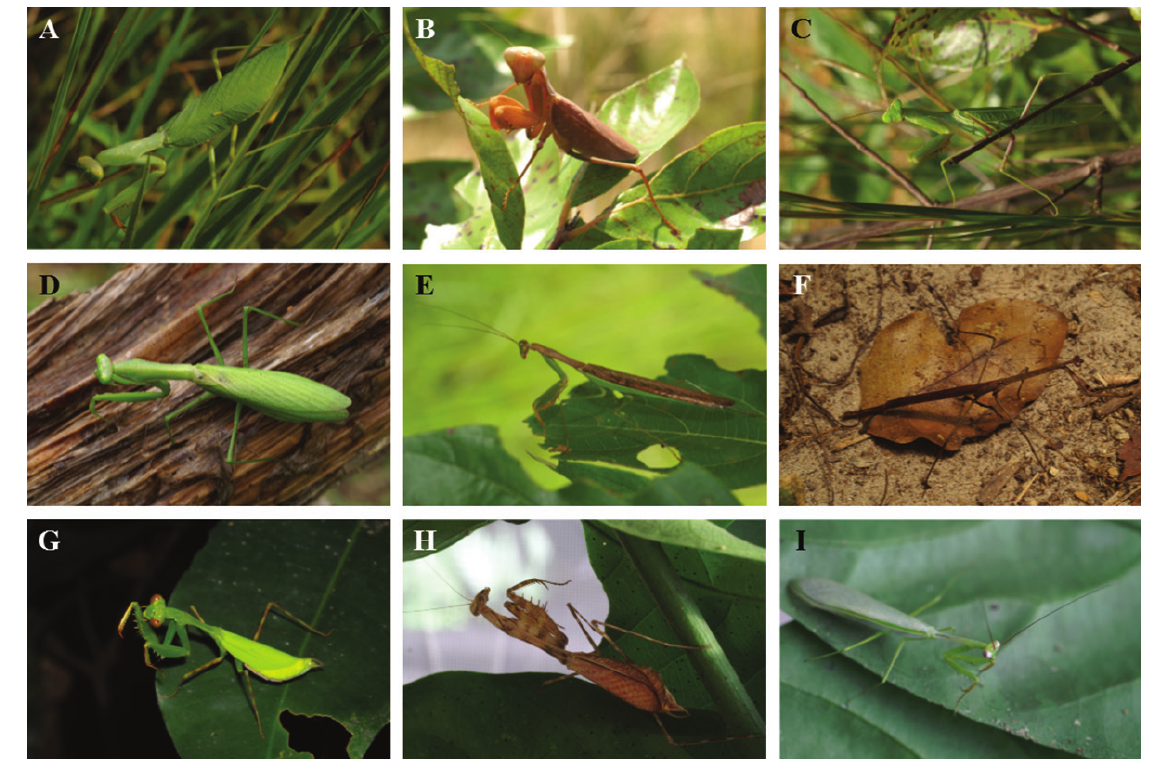
Fig. 3. Live habitus. A. Sphodromantis lineola pinguis (green female) from LNP; B. Sphodromantis lineola pinguis (brown female) from LNP; C. Sphodromantis lineola pinguis (green male) from LNP; D. Alalomantis muta (female) from CMNP; E. Polyspilota aeruginosa (male) from LNP; F. Macrodanuria elongata (male) from DNNP; G. Miomantis preussi (green female) from DNNP; H. Miomantis preussi (brown female) from DNNP; I. Miomantis preussi (male) from